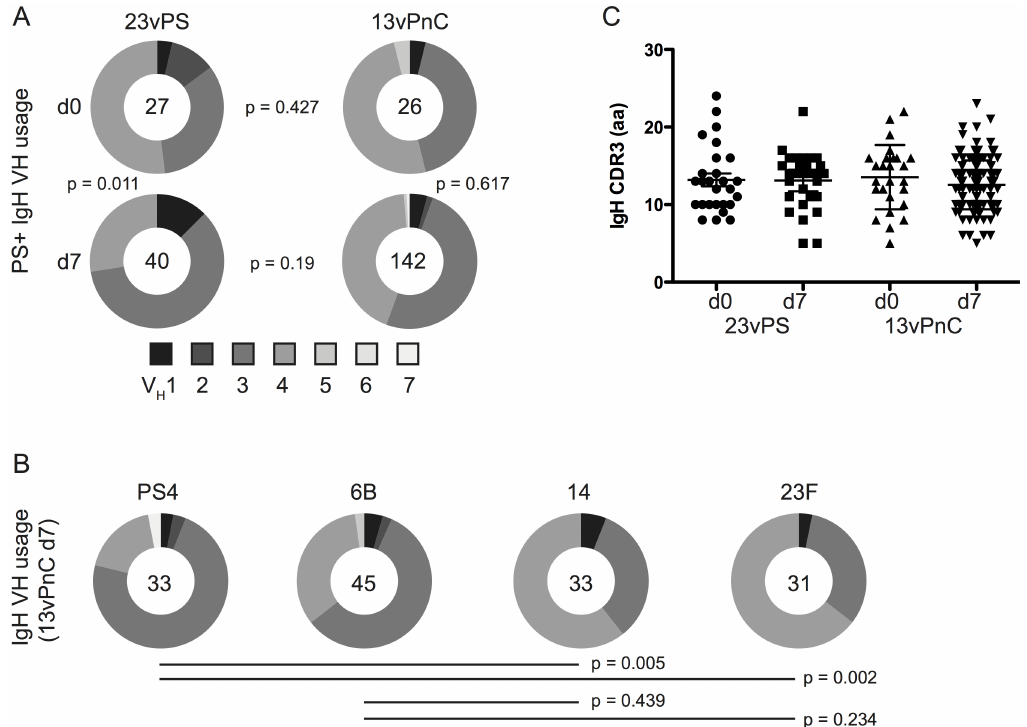
Fig 3. The heavy-chain gene-family usage and CDR3 length of polysaccharide-specific memory B cells. Sequencesrecovered from PS-specific MBCs were analyzedby IMGT/HighV-QUEST using the rhesus macaque immunoglobulin database. The heavy chain allelesof each B cell were generatedby RT-PCR. (A) Heavy-chaingene- family usageat day 0 and 7 after immunizationwith 23vPS or 13vPnC. The numberin the pie chart is the average number of variablesequencesrecoveredfrom PS-specificMBCs. Pairwisestatistical analysiswas performed by Fisher’s Exact Test. (B) Distributionof heavy-chain gene-familyusage for each PS serotype from PS-specificMBCs at 7 days followingimmunization with 13vPnC. The number in the pie chart is the averagenumberof PS-specific MBCs against each antigen. Statistical analysiswas performed by Fisher’s Exact Test. (C) The averageCDR3 amino acid length of PS-specific MBCs at 0 and 7 days after